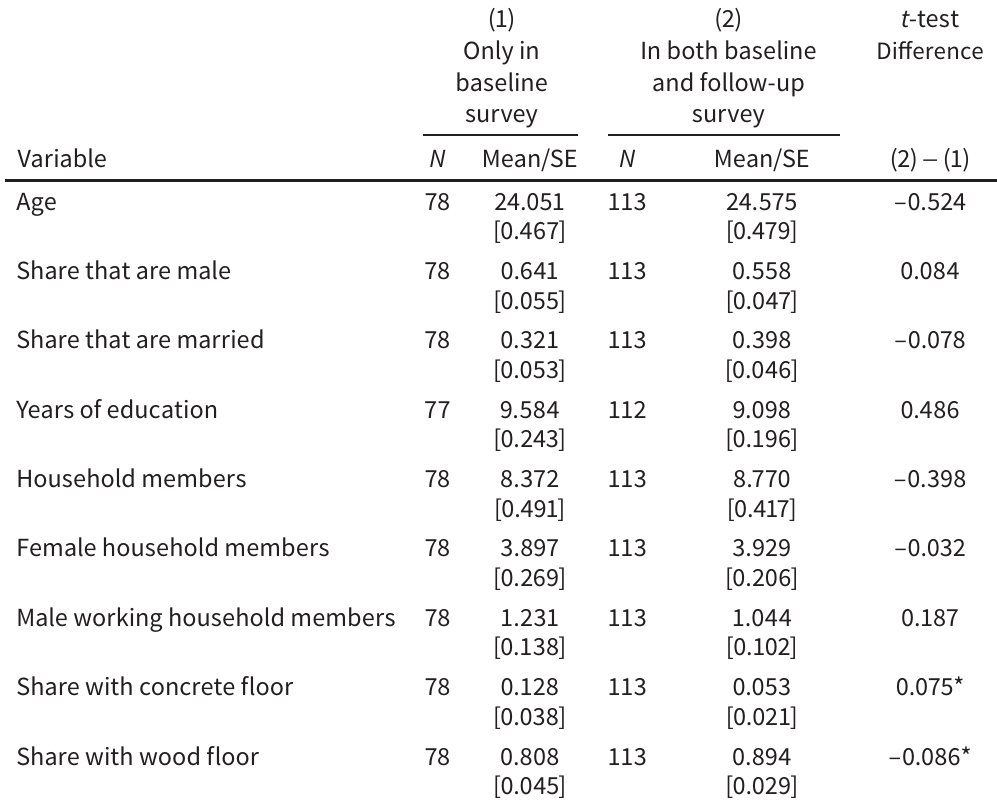
Table A2 Difference in background characteristics of respondents between who were re-interviewed and those that were not in the control group